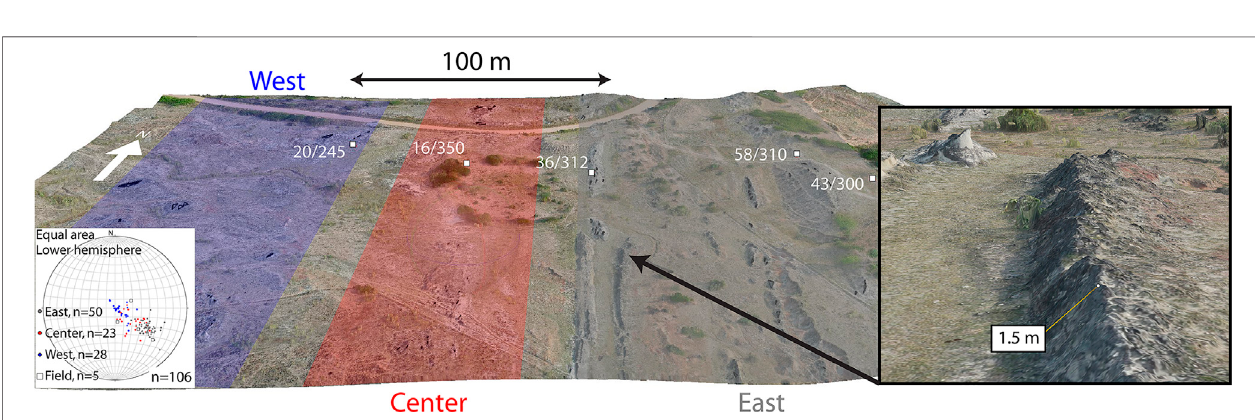
FIGURE 8 | Spatial attitude of bedding in the western fl ank of La Peralta Anticline showing three northwestern-dipping domains display progressively higher dips (quadrangle F3 in Figure 4 ). Field data (red dots) corroborates 3D model measurements (black dots). Inset shows render of steeply dipping strata.